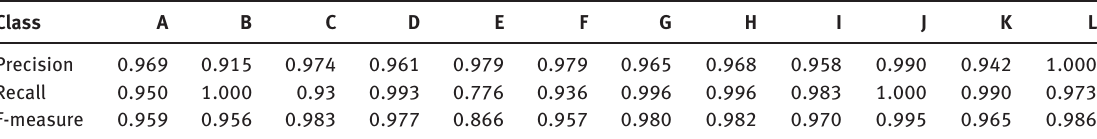
Table 2: Detailed Performance Measures of the Individual Script Classes for the Best Performing Scheme at Text-Line